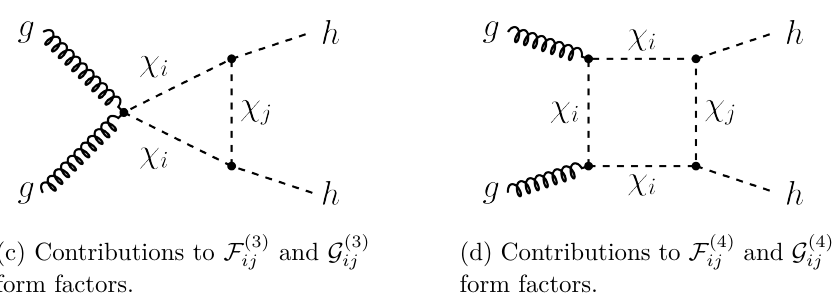
Figure 2. Generic diagrams that contribute to the new physics form factors of gluon fusion into Higgs pairs, mediated by scalar